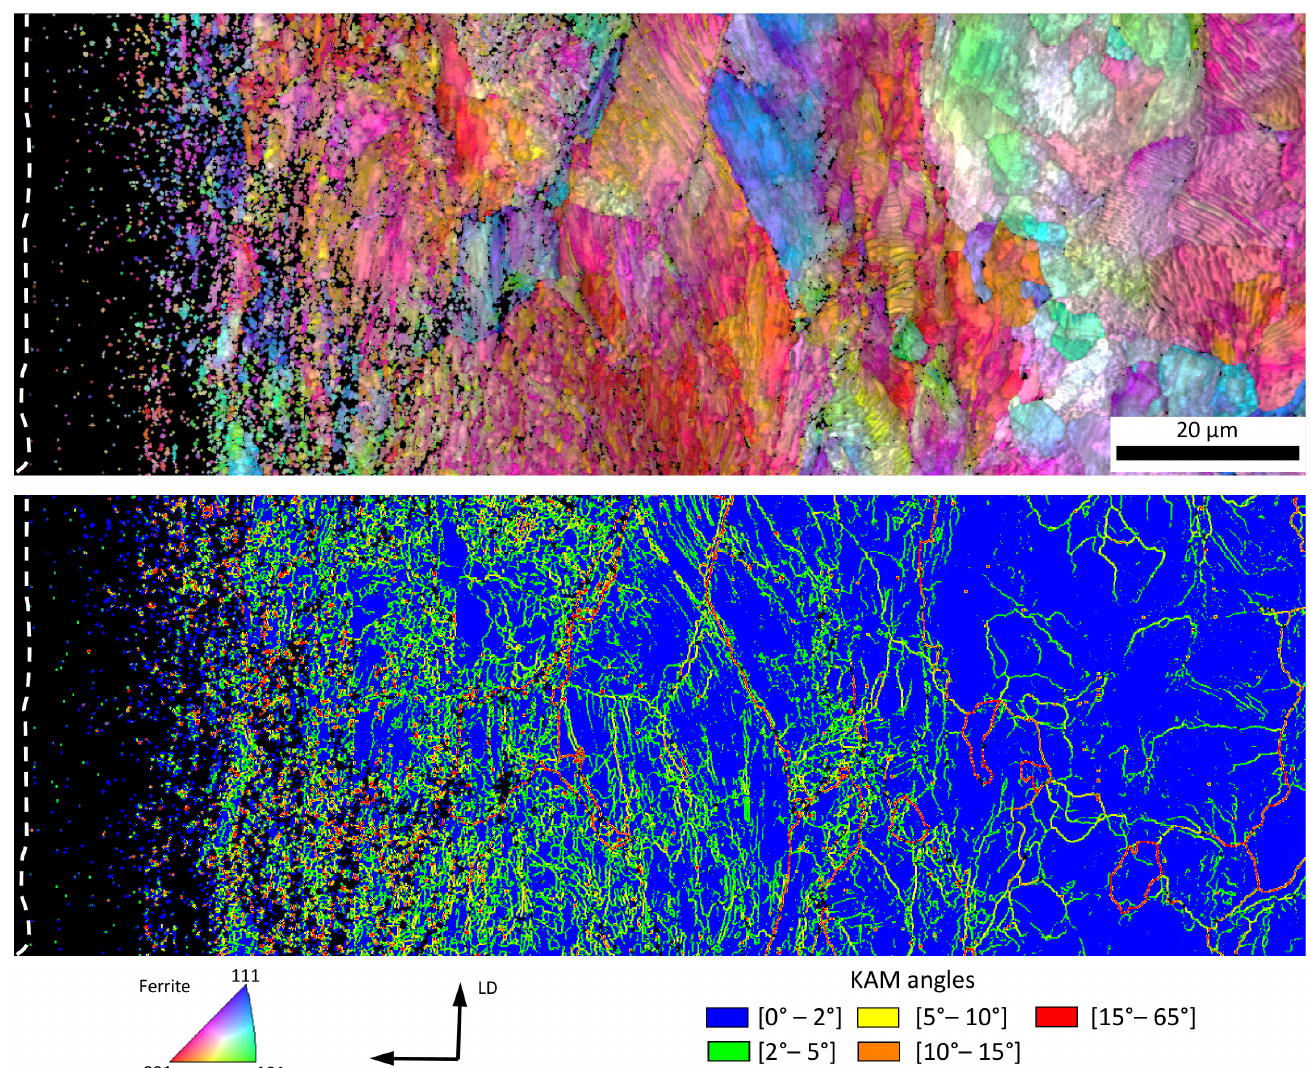
Figure 6. IPF map with IQ and KAM maps of a larger region for AT_T1 (as-turned with 1000 cycles with no sliding). The measurements were performed along the longitudinal direction.